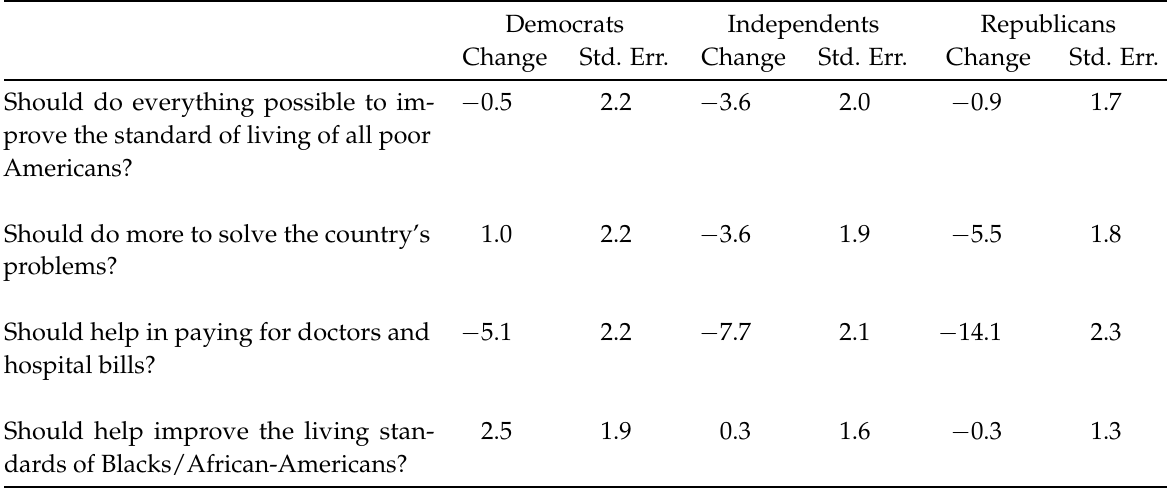
Table 3: Changes between 2004-2008 and 2010-2014 in Attitudes Toward the Responsibility of the Government in Washington Democrats Independents Republicans Change Std. Err. Change Std. Err. Change Std.